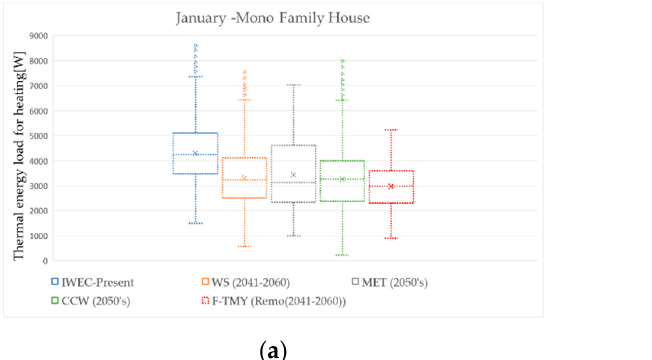
Figure 3. Net thermal energy needs for heating and cooling normalized by the conditioned floor area for a mono family house ( a ) and apartment block ( b ) for IWEC (Present), Weathershift (WS), Meteonorm (MET), CCWorldWeatehr-Gen (CCW), and F-TMY. All future weather files are for 2050s considering RCP 8.5.